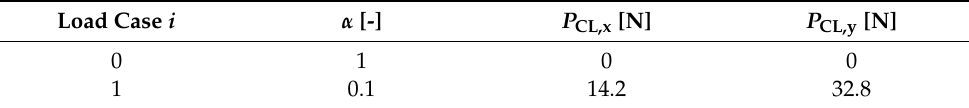
Table 7. Load cases for the rib